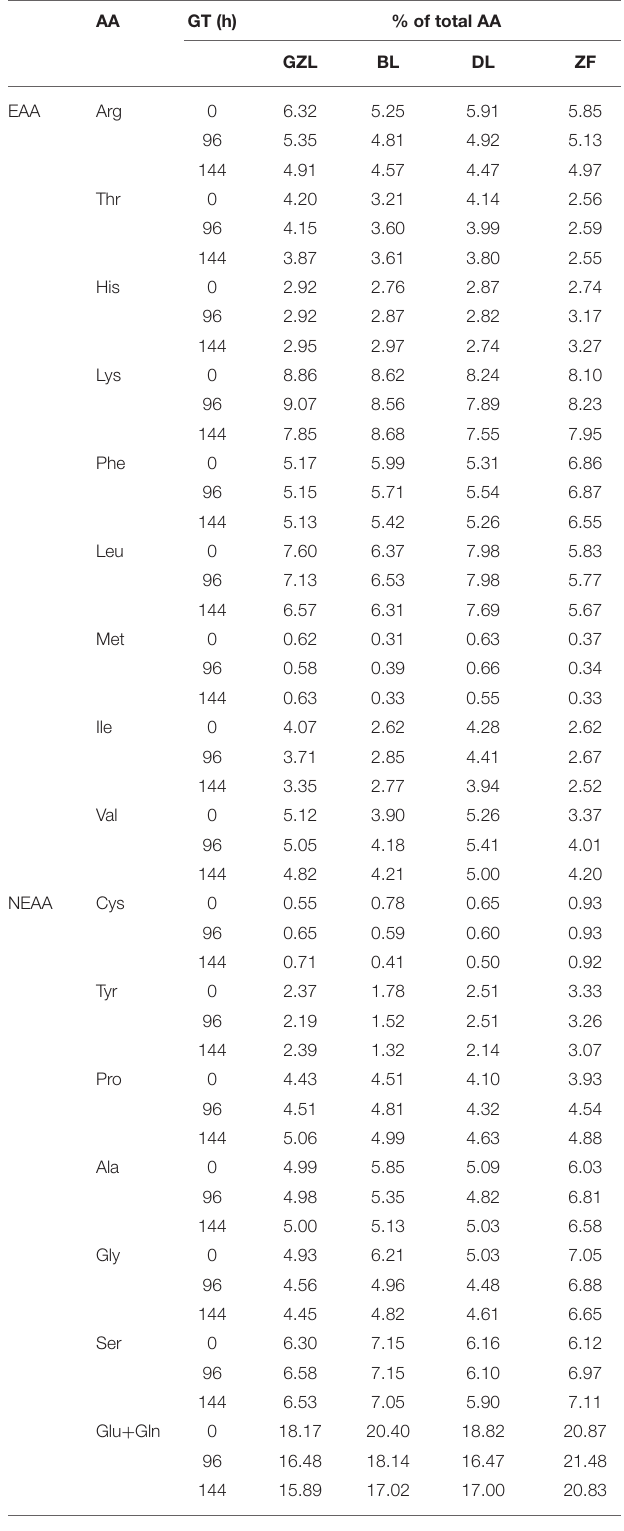
TABLE 2 | The distribution of essential amino acids (EAA) and non-essential amino acids (NEAA) in raw and sprouted legume flours at different times of germination (96 and